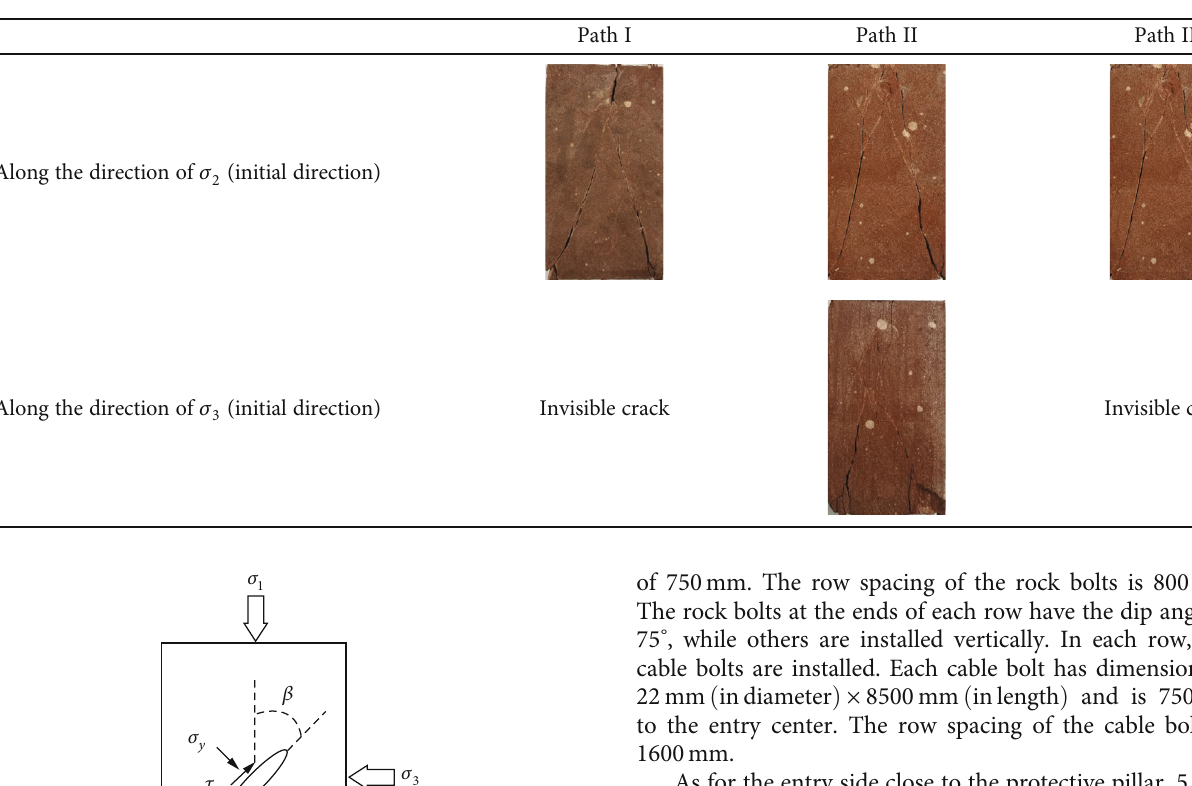
Figure 12: Variation of acoustic emission parameters of rocks under typical stress paths. Table 3: Fracture characteristics of rocks under di ff erent true triaxial loading and unloading conditions.